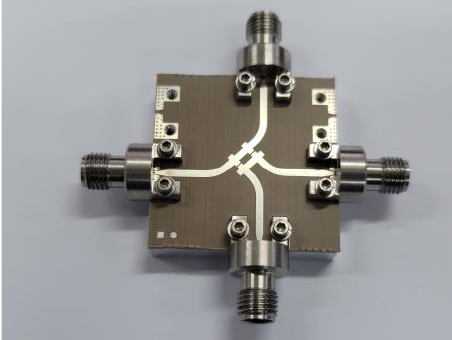
Figure 9. The fabrication of the proposed coupler.